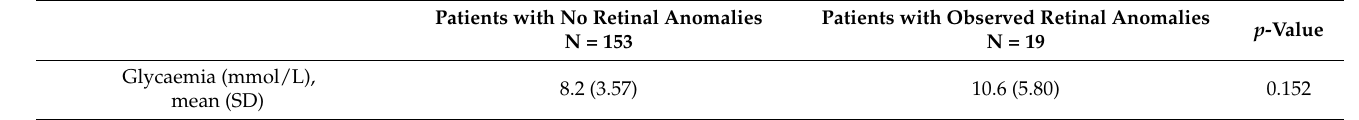
Table 1. Cont . Patients with No Retinal Anomalies N = 153